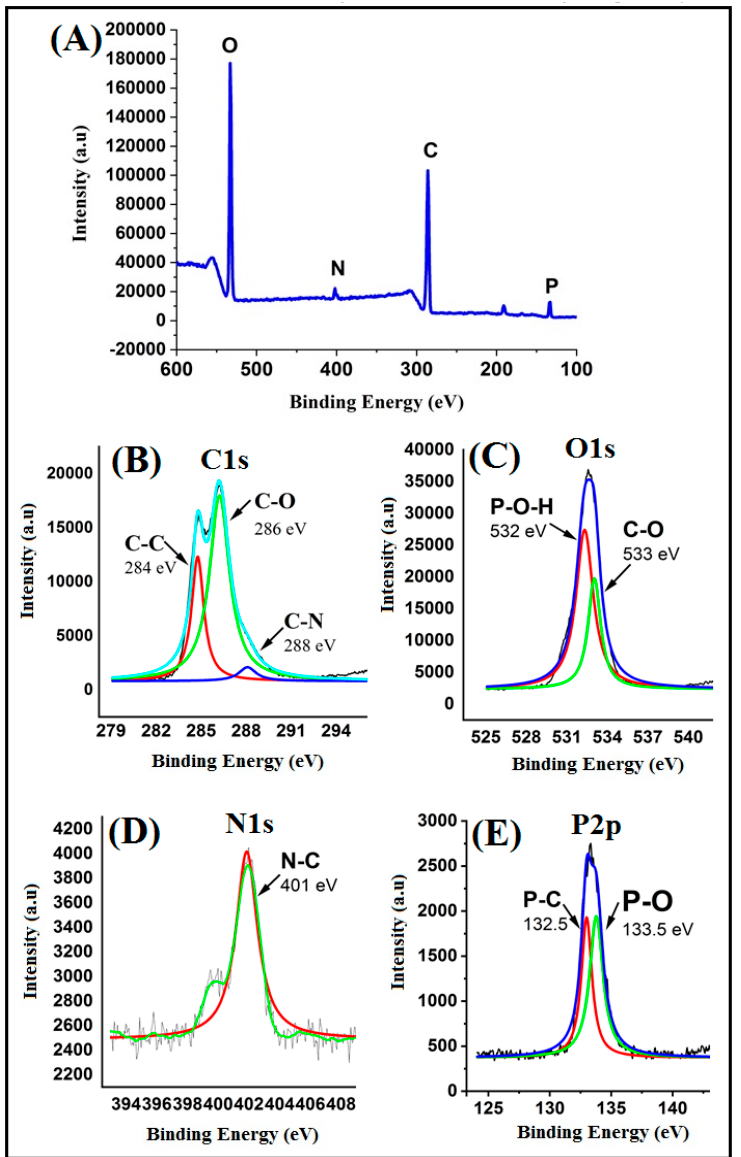
Figure 4. ( A ) XPS wide scan survey spectra of APBC nanofibers and deconvoluted high-resolution scans for ( B ) C1s; ( C ) O1s; ( D ) N1s and ( E ) P2p.